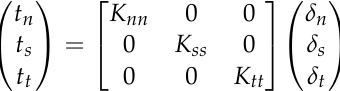
Figure 8. Flow chart of simulation procedure between 2D Hashin and 3D Hashin VUMAT models. 3.4. Failure Criteria and Damage Evolution Law for Interface The cohesive element model is widely used to model delamination in composite lam- inates. Based on the traction separation criterion, the constitutive relationship of cohesive force element idealises the complex fracture mechanics problem. The specific expression is as follows: